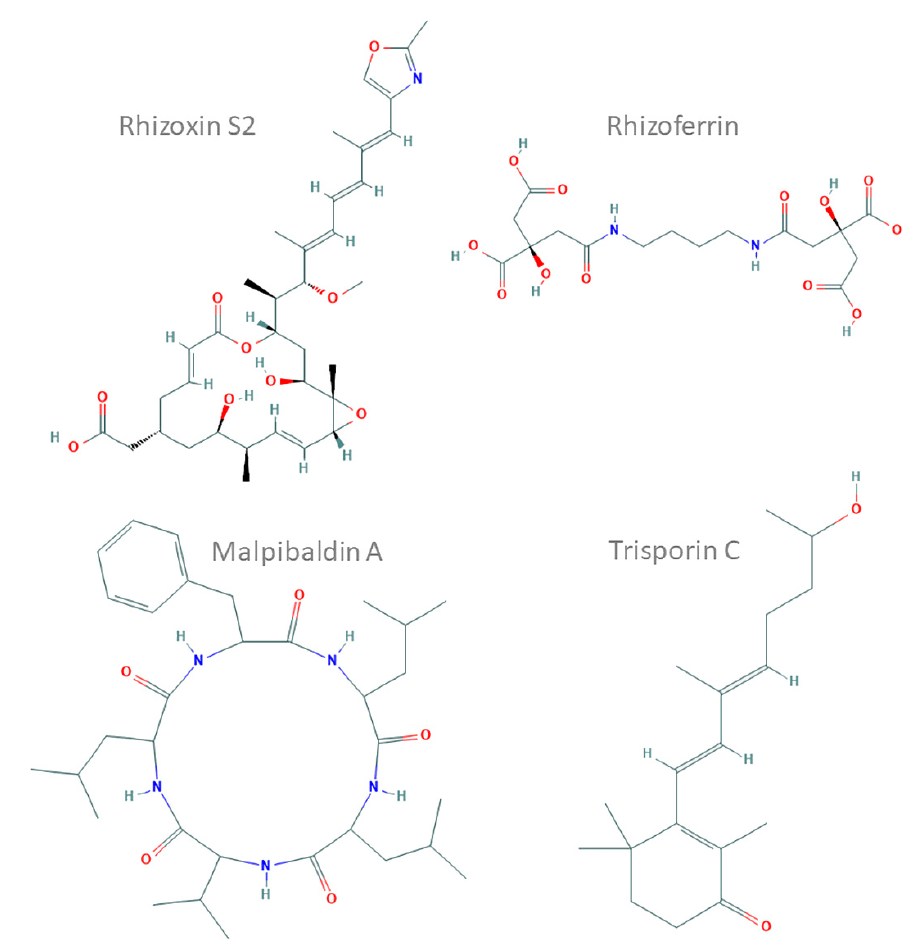
Figure 1. Chemical structures of representative compounds characterised in Mucoromycotina pre- pared and based on ChEMBL records (compound IDs: 44521071, 9845871, 102170144 and 72981718). Rhizoxin S2, a hybrid nonribosomal peptide synthetase (NRPS)–polyketide synthase (PKS) toxin from Rhizopus microsporus ; rhizoferrin, a non-NRPS siderophore from Rhizopus spp.; malpibaldin